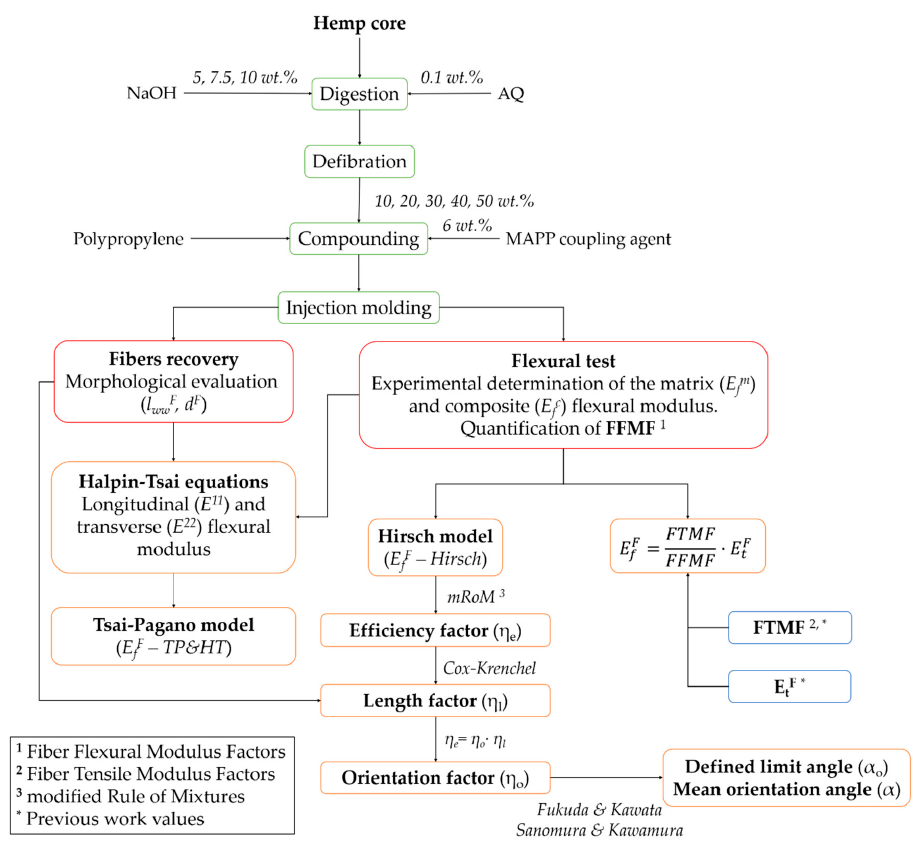
Figure 3. Investigation work plan.